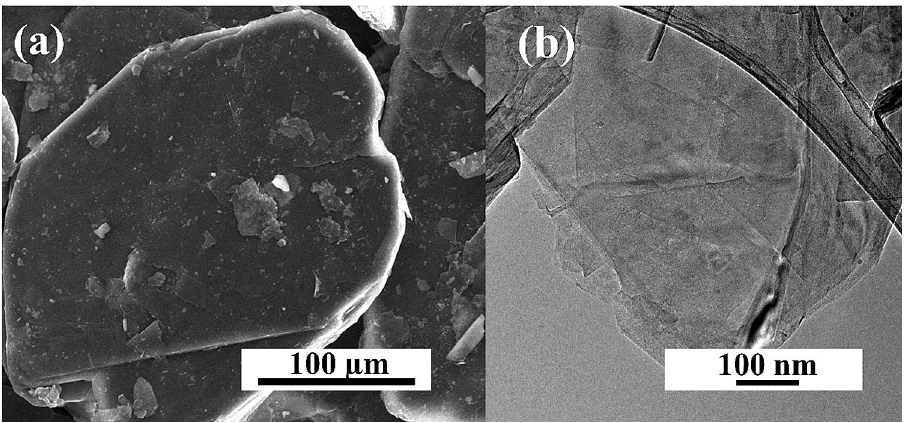
Figure 1. ( a ) SEM and ( b ) HRTEM images of expanded